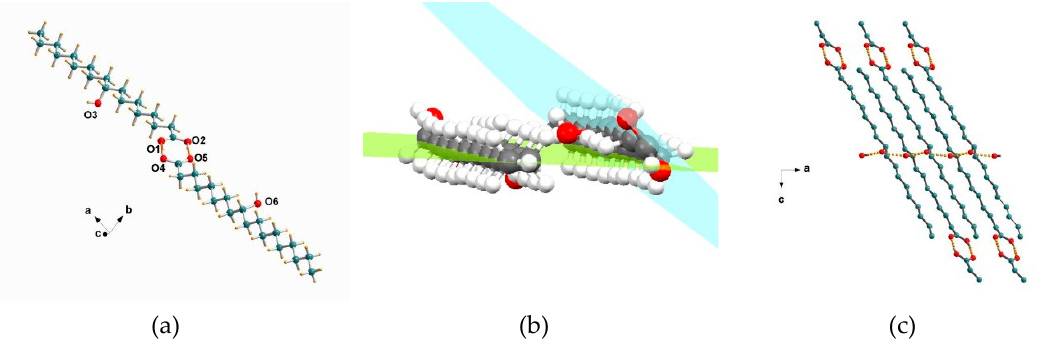
Figure 6. Crystal structure of (R) -9-HSA crystallized from methanol: ( a ) the (R) -9-HSA dimer, crystallographic independent unit, with molecule 1 on the left side and molecule 2 on the right side. ( b ) Average planes across the carbon atoms of the alkyl chains of the dimer. The dihedral angle is 38.8°. ( c ) Head-tail packing.